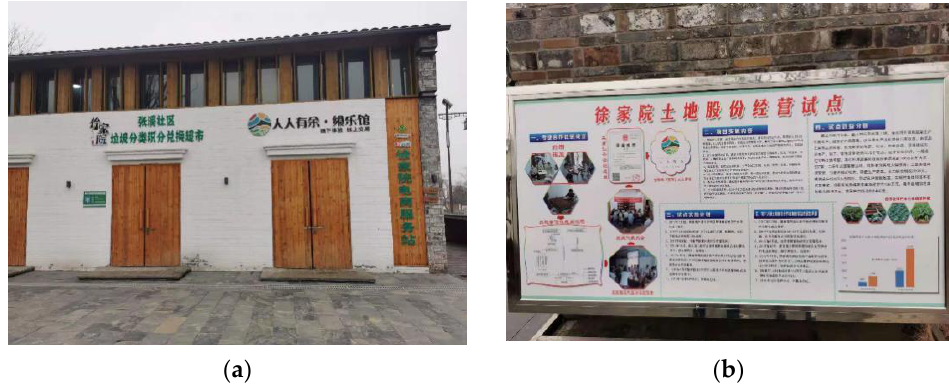
Figure 4. Current situation of Xujiayuan village construction: ( a ) Xujiayuan community service station; and ( b ) sketch map of land share operation pilot.